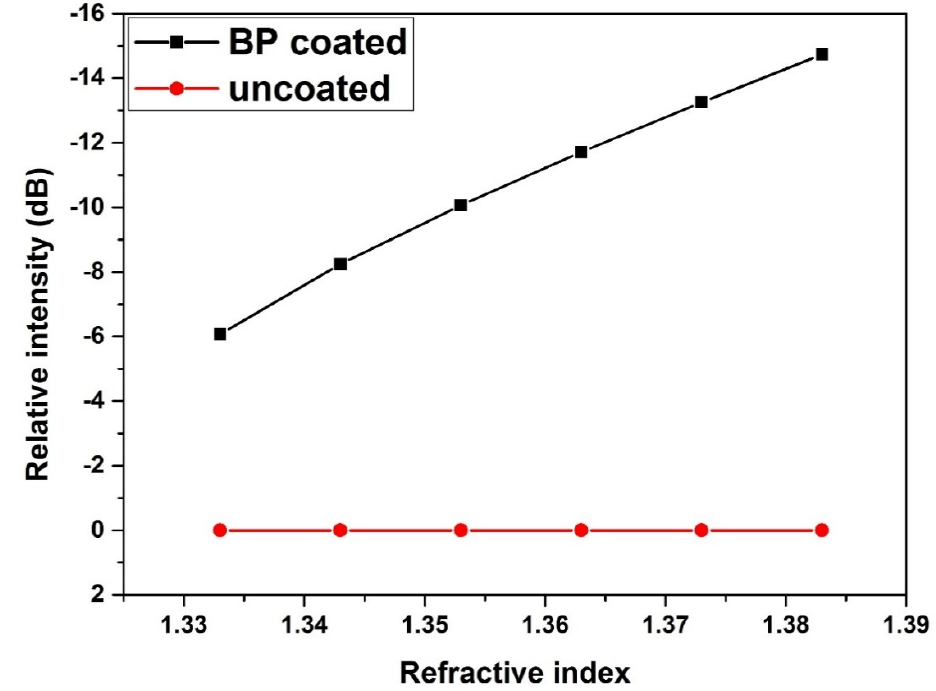
Figure 2. Simulation results of the relative transmission intensities of the uncoated and coated black phosphorus (BP) film structures for cladding modes of weakly tilted fiber Bragg grating (WTFBG) at 1552 nm with different refractive indices (RIs).